Question: What form of chart is displayed?
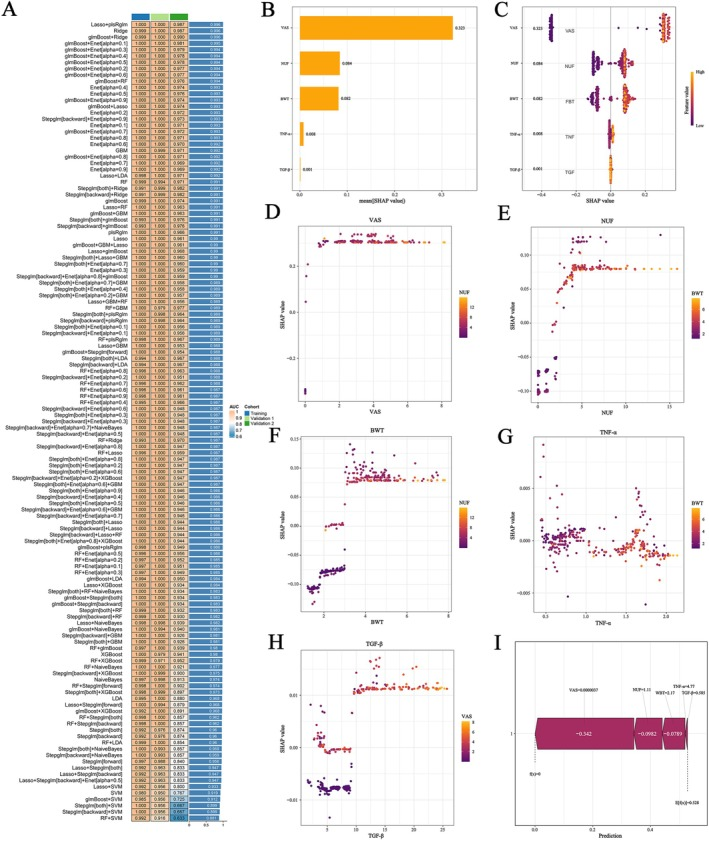
Answer: heatmap